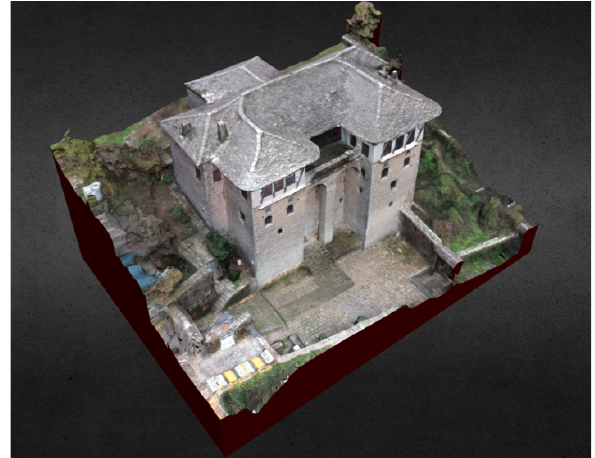
Figure 4. 3D model of Zekate house (© F. Frullini).